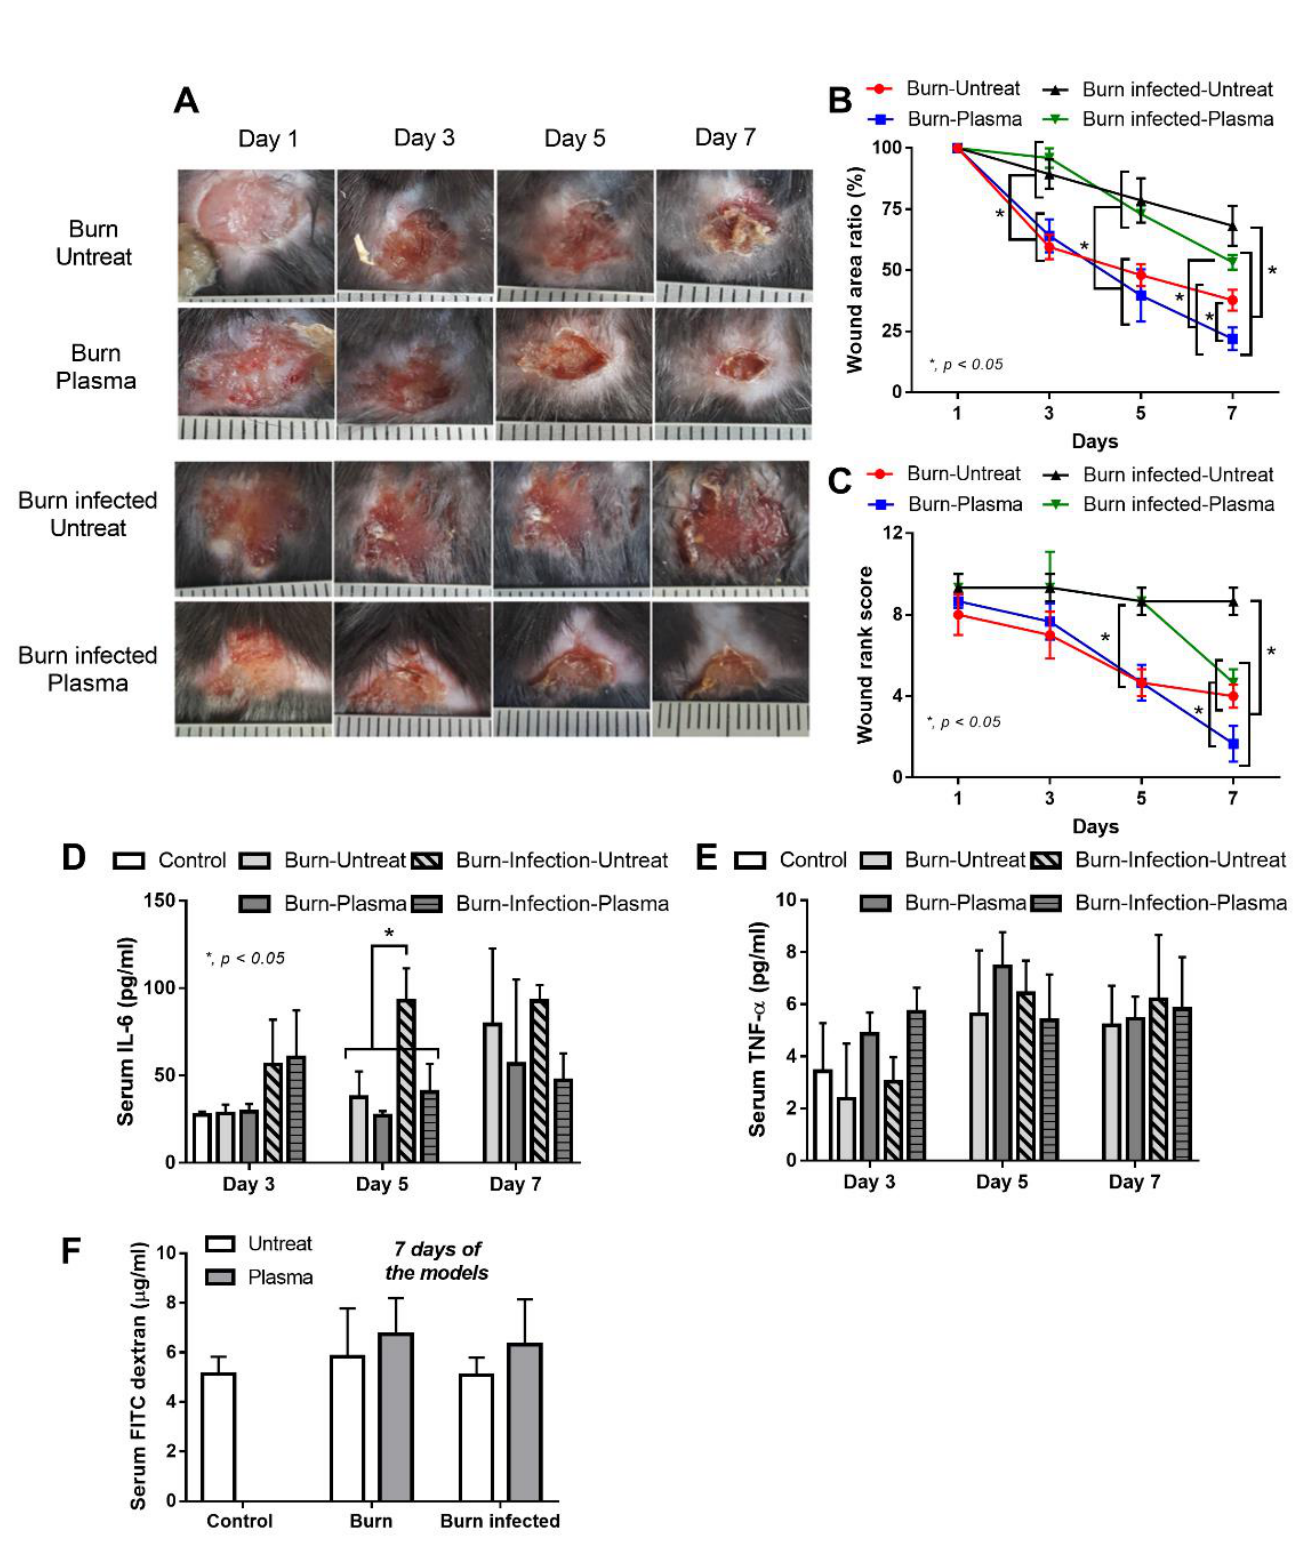
Figure 5. Characteristics of wounds in mouse models with burn injury with or without bacterial infection after treatment by plasma flux (Plasma) or Argon gas alone (Untreat) as determined by wound area and wound rank score (see method) with the representative pictures ( A – C ), serum cytokines (IL-6 and TNF- α ) ( D , E ) and gut permeability measurement (FITC-dextran assay) ( F ) (n = 5–7/time-point or group) are